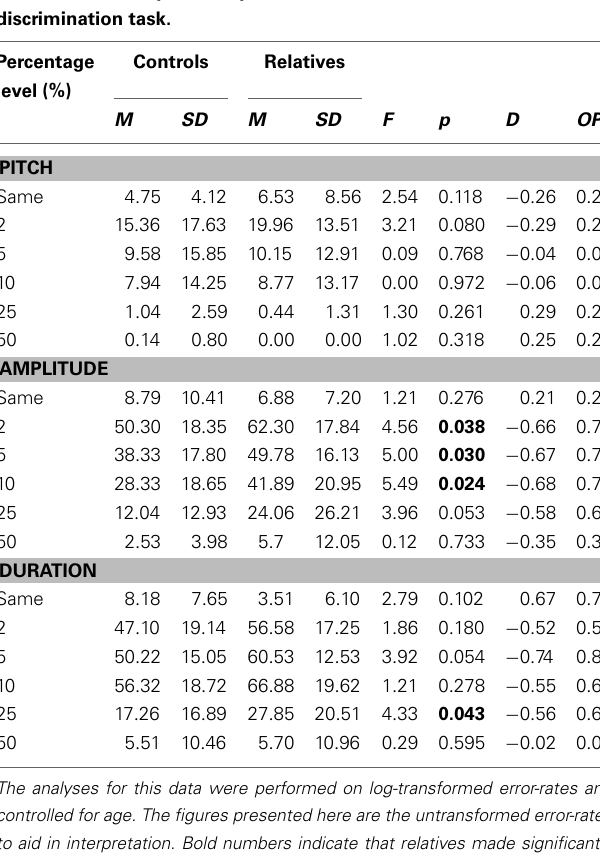
Table 2 | Error rates for controls and relatives across each percentage level difference in pitch, amplitude, and duration on the tone discrimination task.